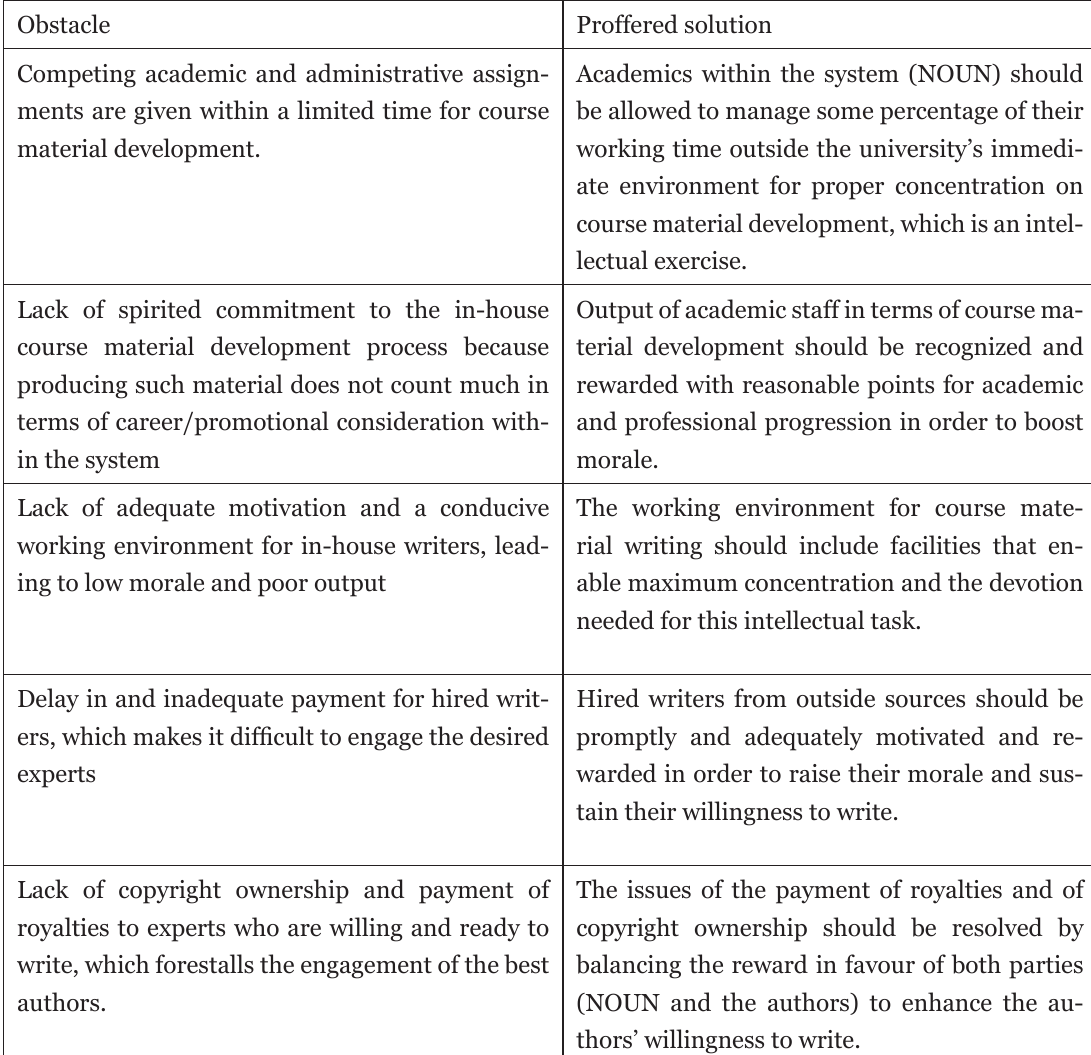
Obstacles to the Desire, Intention, or Determination of Course Material Writers/Develop-